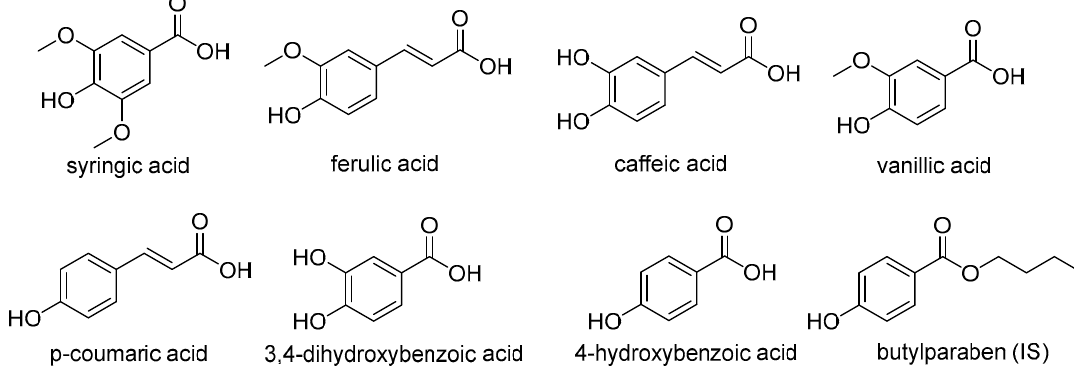
Figure 1. The chemical structures of the seven analytes and the internal standard (IS), butylparaben.